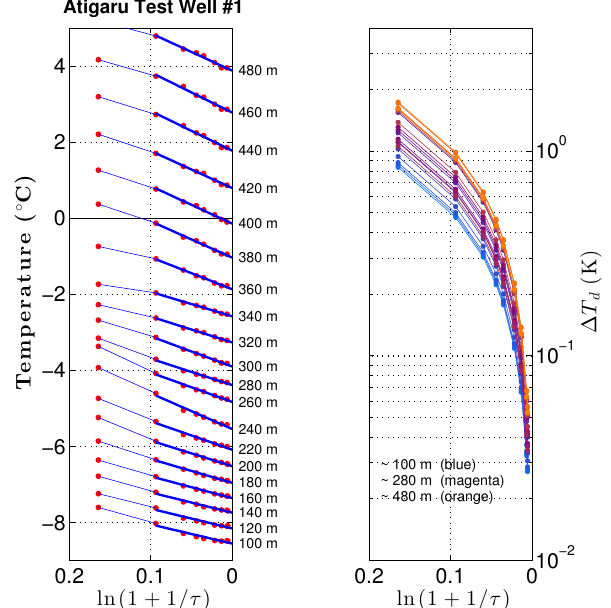
Figure 31. Recovery of temperatures from the thermal drilling disturbance at fixed depths in the Atigaru Test Well No. 1 (left). In this case, the earliest log was obtained at dimensionless time τ = 5 . 6, or ln(1 + 1 /τ ) = 0 . 16 . Complete thermal recovery occurs as ln(1 + 1 /τ ) approaches zero ( τ → ∞ ). A least-squares fit to the temperature data for times τ > 8 provides values for the undisturbed temperature profile T o ( z ) and the factor ¯ q l / (4 π K ) (dark blue lines). With these values, the evolution of the thermal drilling disturbance ∆ T d (right panel) can be found using Eqs. (13) and (14).